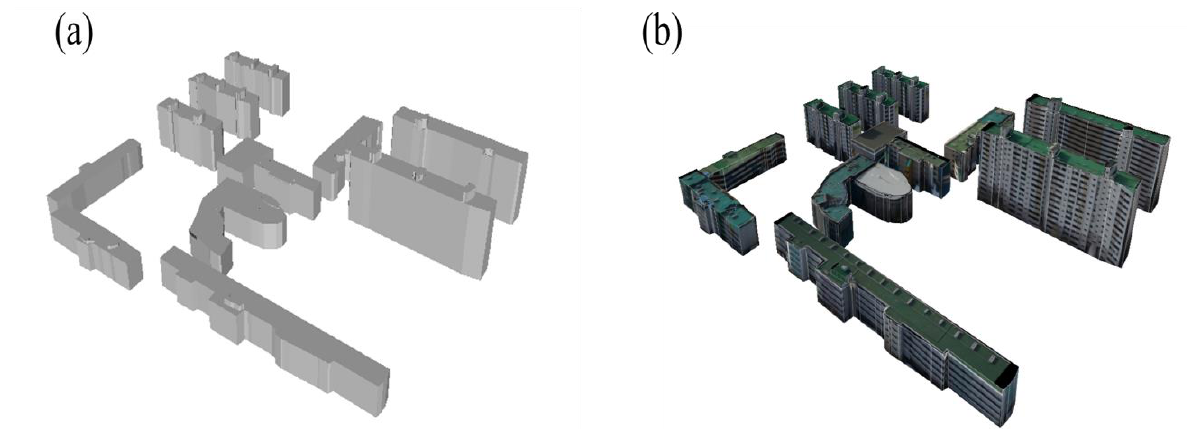
Figure 12 . Building structure(a) and texturing results(b).